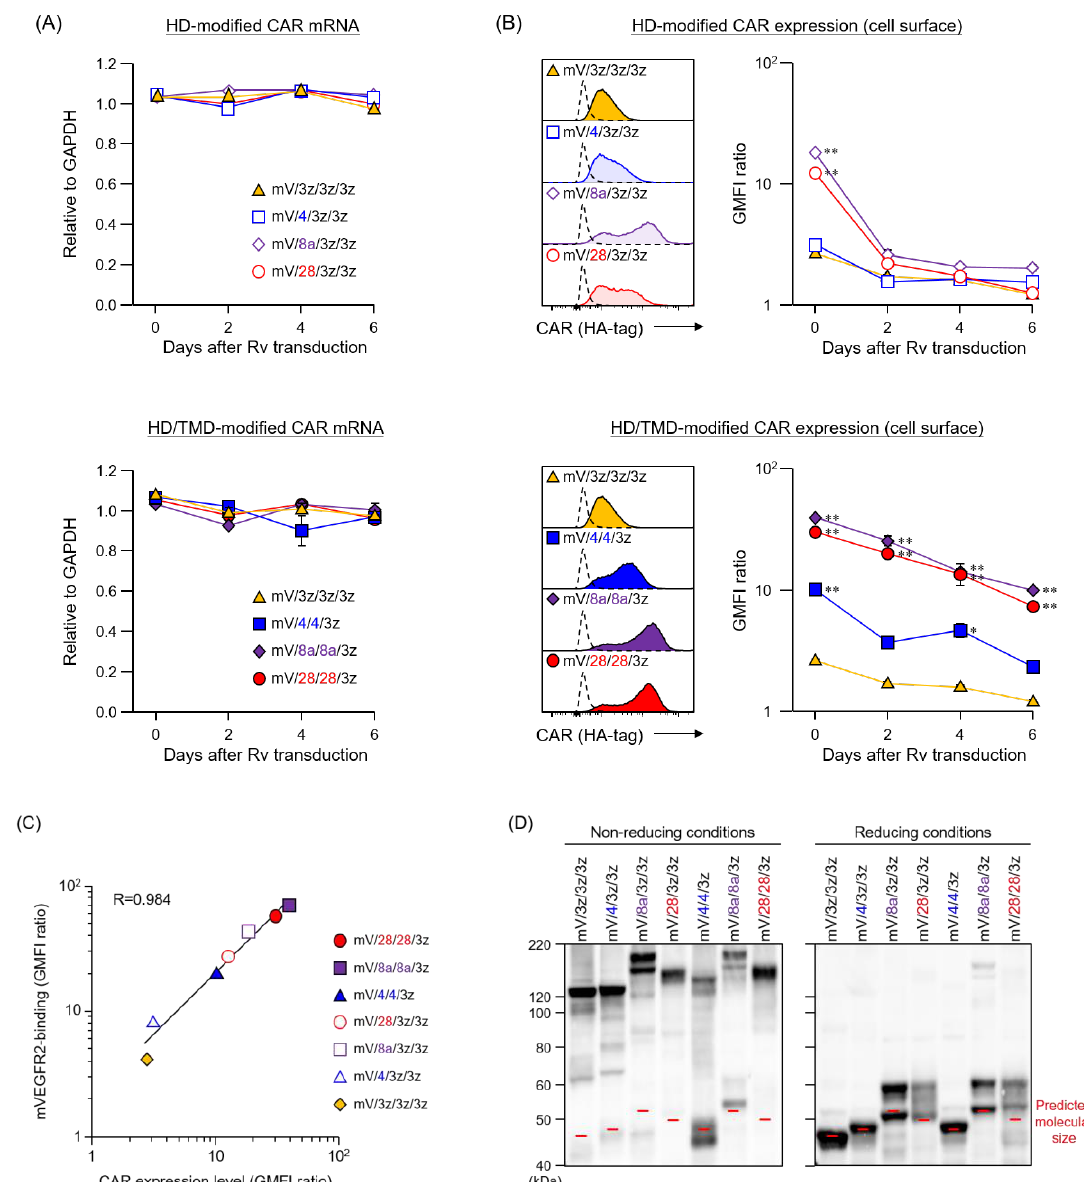
Figure 2. Expression of hinge domain (HD)-modified and hinge / transmembrane domain (HD / TMD)-modified chimeric antigen receptors (CARs) in mouse T cells. ( A ) CAR mRNAs were analyzed by reverse transcription and quantitative polymerase chain reaction, and their transcription levels were calculated relative to GAPDH mRNA as an endogenous control. ( B ) CAR expression on T cells were analyzed by flow cytometry using anti-HA-tag mAb (solid color histograms) or isotype control antibody (dashed white histograms). Each CAR expression level was calculated from the ratio of geometric mean fluorescence intensity (GMFI) when stained with the anti-HA-tag mAb to GMFI when stained with the isotype control antibody. ( C ) The mouse VEGFR2-binding of CAR-T cell on day 0 was analyzed by flow cytometry using an mVEGFR2-Fc chimera, and the relationship between the CAR expression level and mVEGFR2-binding of CAR-T cells was evaluated. ( D ) CAR proteins in the whole lysate were analyzed by sodium dodecyl sulfate-polyacrylamide gel electrophoresis and western blot analysis using anti-HA-tag mAb on day 0. The data were obtained from three independent tests. Statistical analysis was performed using Dunnett’s test against mV / 3z / 3z / 3z, * p < 0.05; ** p < 0.01.